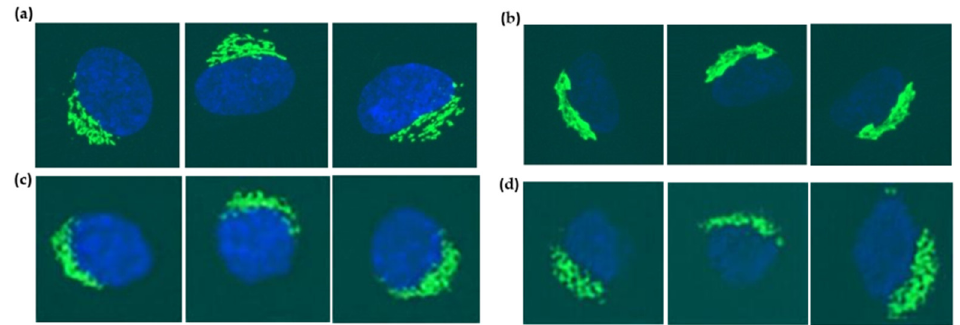
Figure 9. The images of the G2 class and the non-G2 class. ( a ) Images of G2 class [13]; ( b ) images of non-G2 class [13]; ( c ) images generated by WGAN-GP of G2 class; ( d ) images generated by WGAN-GP of non-G2 class. Table 9. The classification results for original images and generated images.